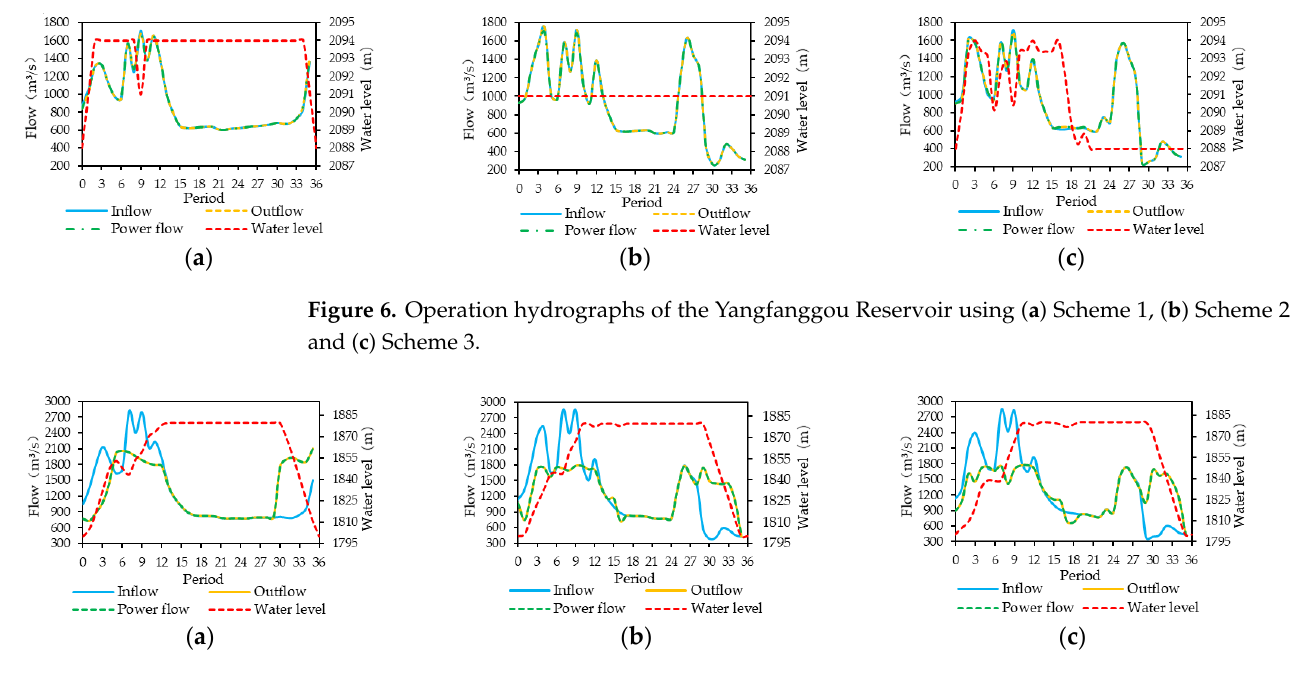
Figure 5. Operation hydrographs of the Lianghekou Reservoir using ( a ) Scheme 1, ( b ) Scheme 2 and ( c ) Scheme 3.